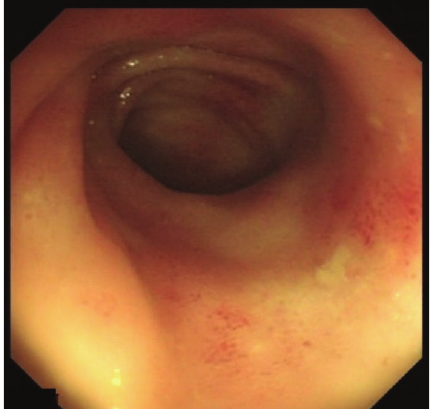
Figure 5: Terminal Ileum showing patchy erythematous